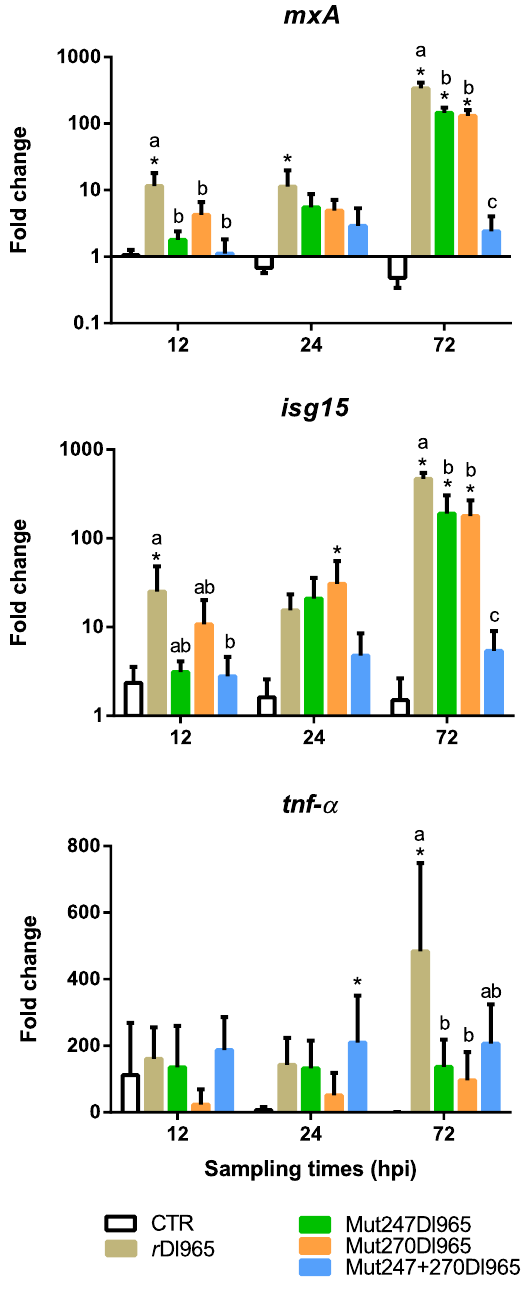
Figure 4. Relative quantification of mxA , isg15 and tnf- α transcription after inoculation with r Dl965 or mutated viruses. Data were statistically analysed with the one-way ANOVA test. Asterisk indicates significant differences between L-15-injected (negative control) and virus-inoculated fish within each sampling time (p < 0.05). Different letters denote significant differences among experimental groups at the same sampling time (p < 0.05). Results are mean ± s.d. (n =